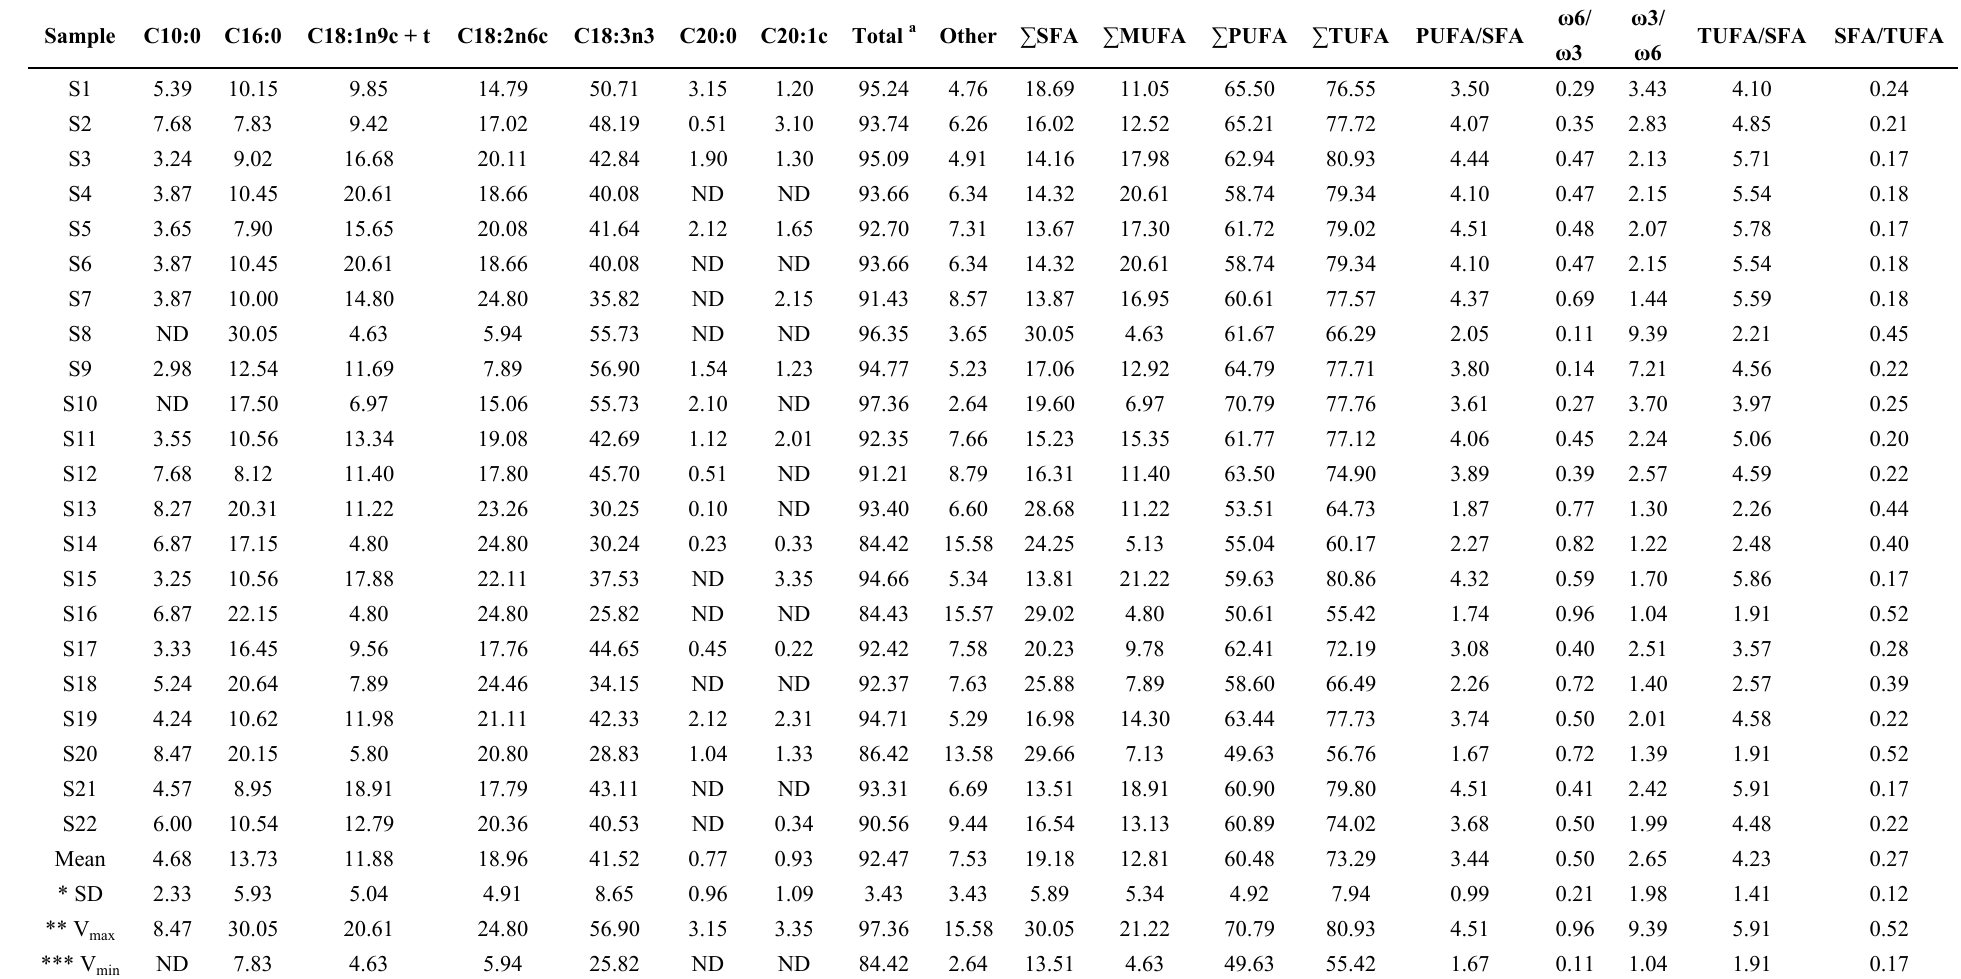
Table 4. Fatty acid profile of the organic apian